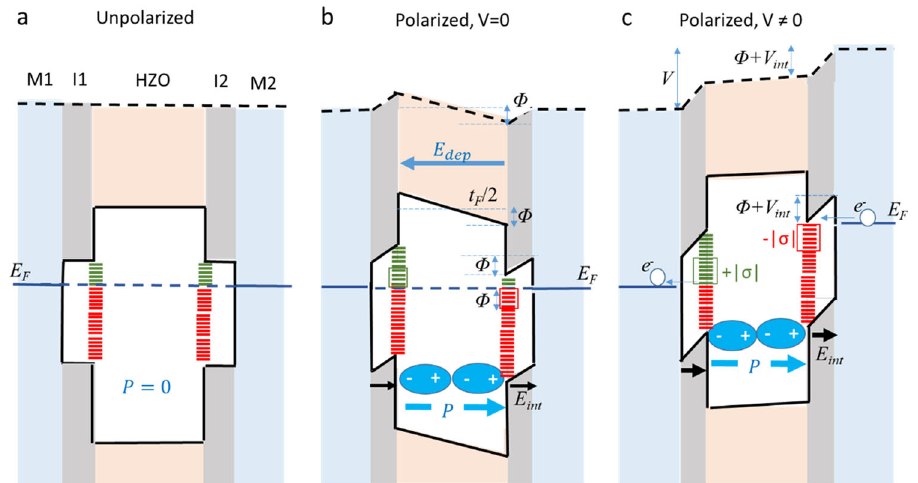
Fig. 6 Schematic illustration of trap fi lling controlled by Polarization P and Voltage V. Depicts an idealized Hf 0.5 Zr 0.5 O 2 (HZO) Metal-Insulator- Ferroelectric-Insulator-Metal (MIFIM) capacitor with symmetric interfacial layers and interface defect density, uniformly distributed in energy. a Unpolarized MIFIM with charge neutral interfaces showing fl at bands in equilibrium. b Polarized MIFIM in equilibrium ( V = 0) showing depolarization and interfacial fi elds E dep and E int respectively. P is the polarization and Φ is the electron potential lowering at the interface due to the positive polarization charges at the interface on the right. c The MIFIM at a fi nite bias V establishing a fi eld parallel to the polarization. V int is the voltage drop at the interfacial layers resulting in a total Φ + V int electron potential lowering at the interface on the right. The potential lowering creates a trapped charge − | σ | and + | σ | at the opposite interfaces due to the set of trap levels, indicated by red (green) squares, moving below (above) the Fermi energy level E F